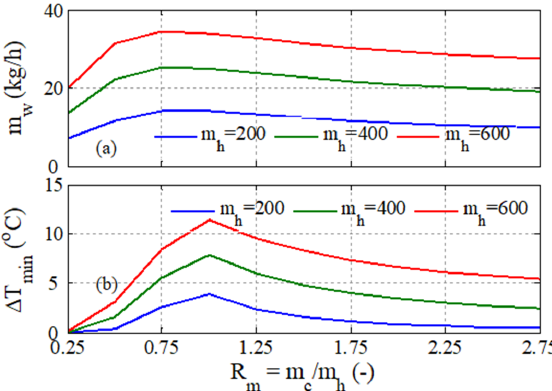
Figure 3. Variation of production rate with feed and permeate flow rates at T h 20 (cid:2925) C . Different colored lines corresponds to different m h values as indicated on the curve itself.